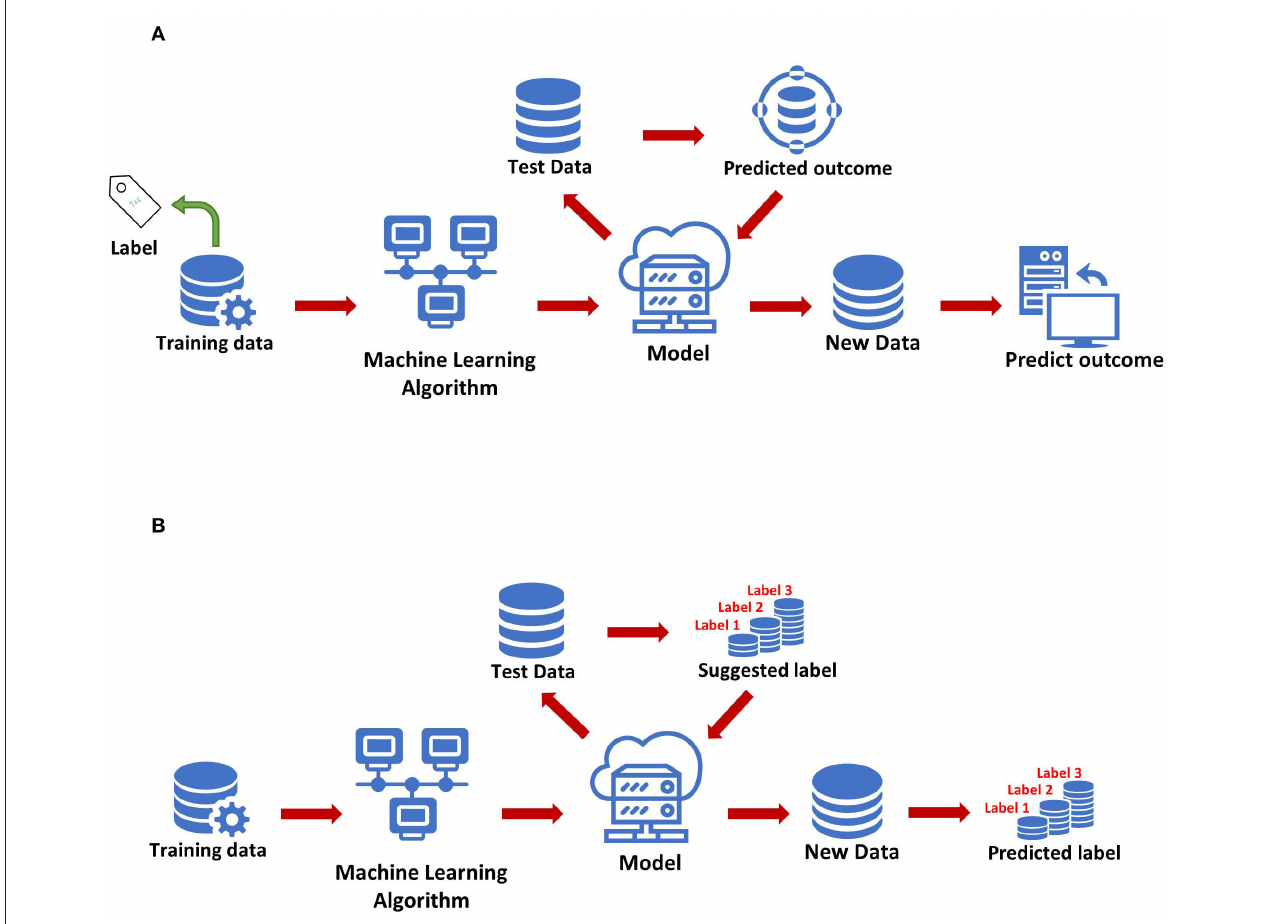
FIGURE 2 | Two methods of machine learning. (A) Supervised learning. (B) Unsupervised